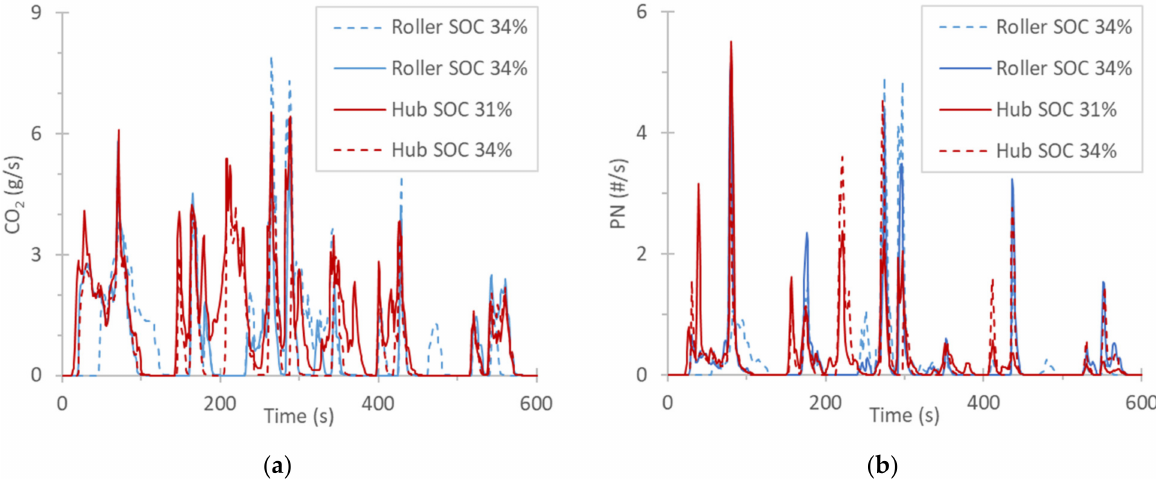
Figure A4. Real-time emissions during the first 600 s of cold-start WLTCs for tests with similar starting state of charge (SOC) of the high-voltage battery: ( a ) CO 2 ; ( b ) particle number